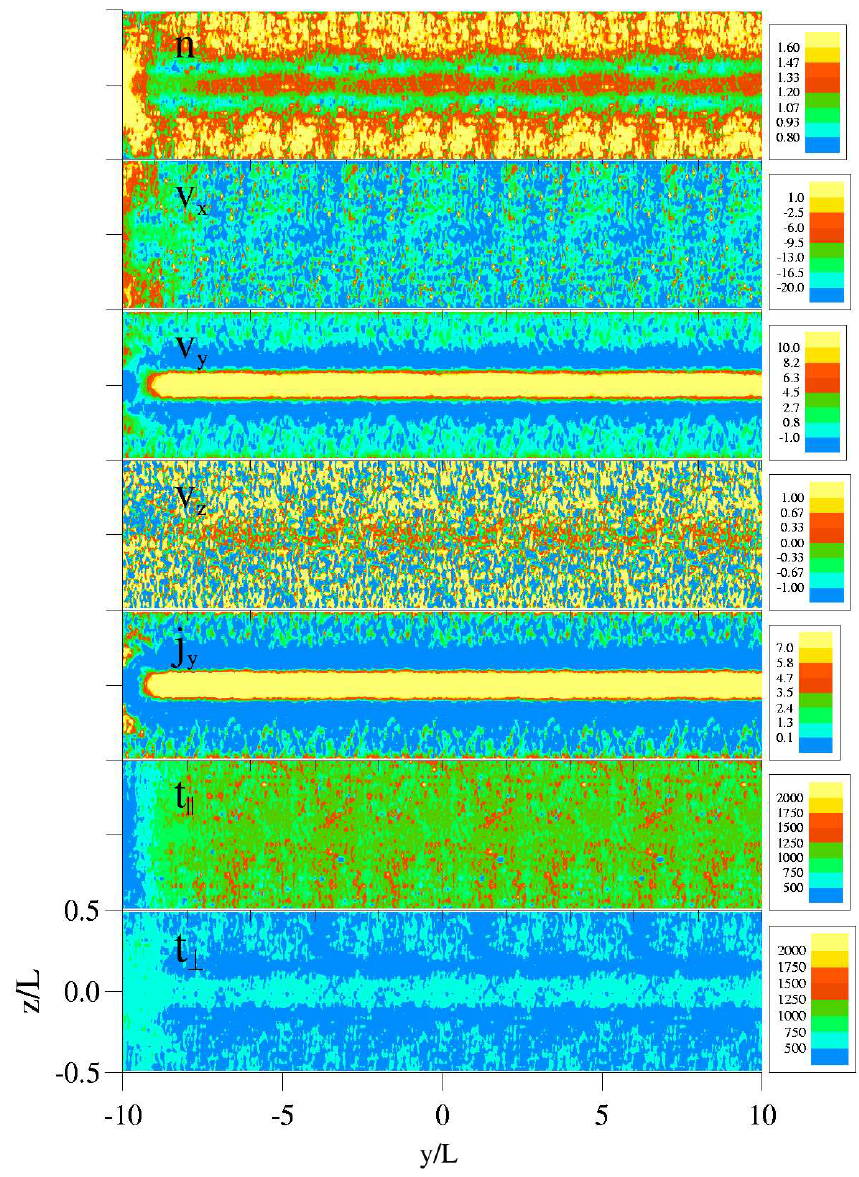
Fig. 1. Contour plots of the ion mo- ments. From top to bottom, the density n , the three components of the bulk ve- locity V x , V y , and V z , the current den- sity j y , the temperatures T k and T ⊥ . For this run δb = 0 and b n = 0 . 05. Density is in units of n ∗ , velocity in units of V E , currents density in units of cB 0 / 4 πL , and temperatures in units of m i V 2 /k B . Color scales on the E